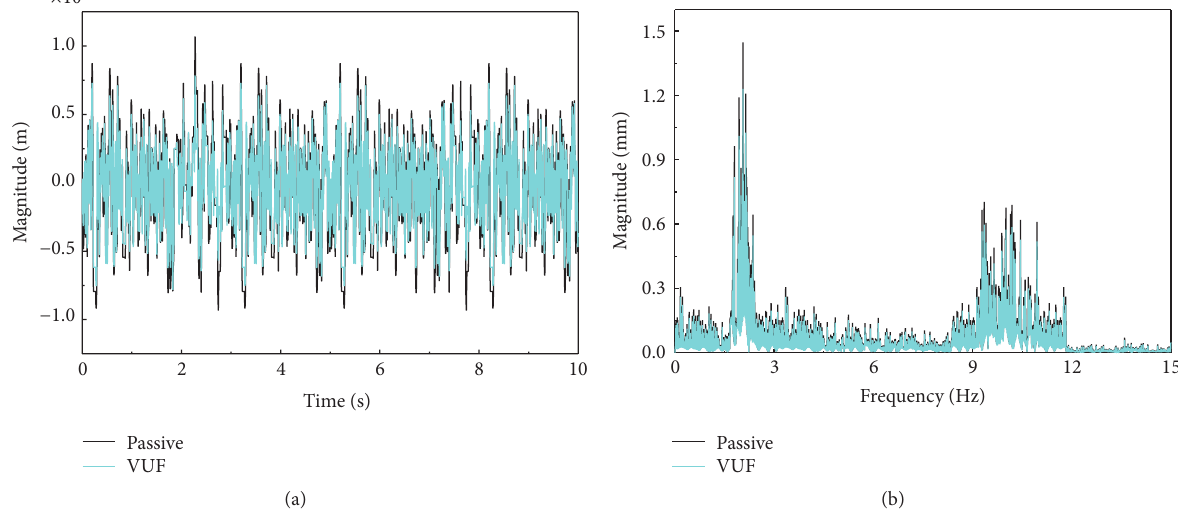
Figure 13: Experimental results of the tire dynamic displacement: (a) time domain and (b) frequency domain.